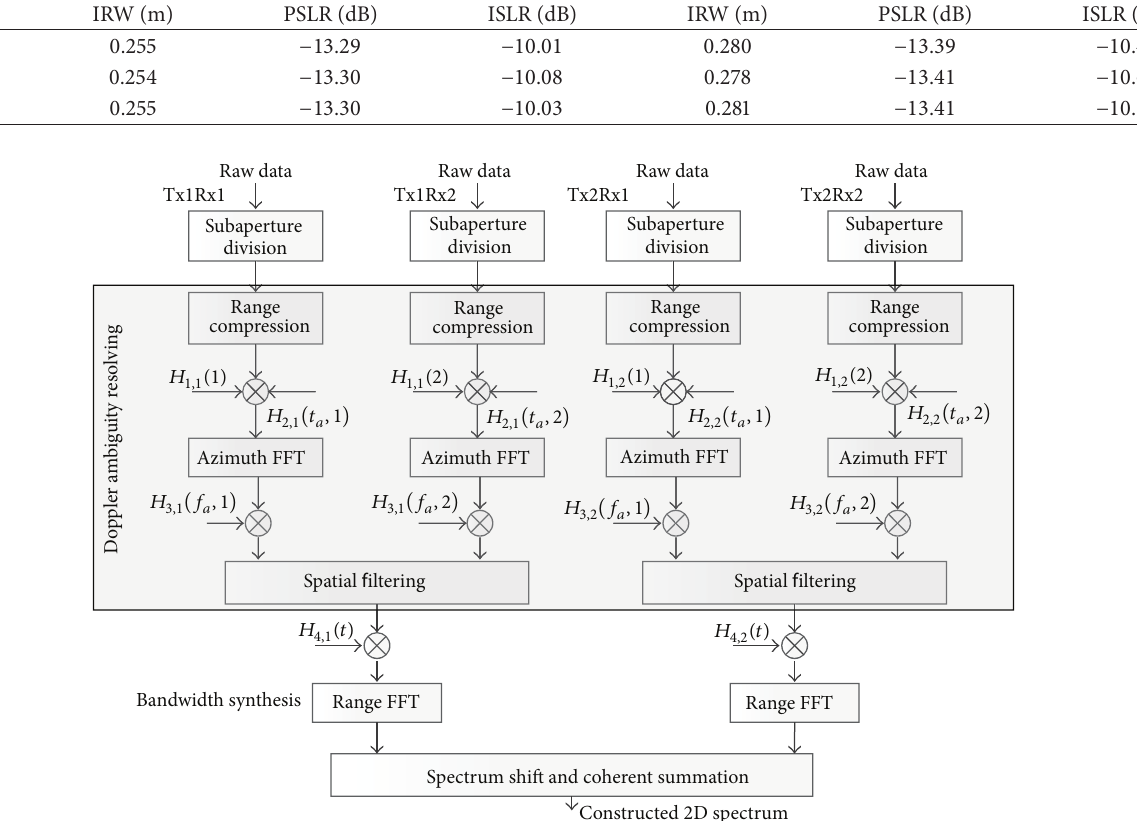
Figure 4: Flowchart of the proposed algorithm ( 𝑁 = 2 ).